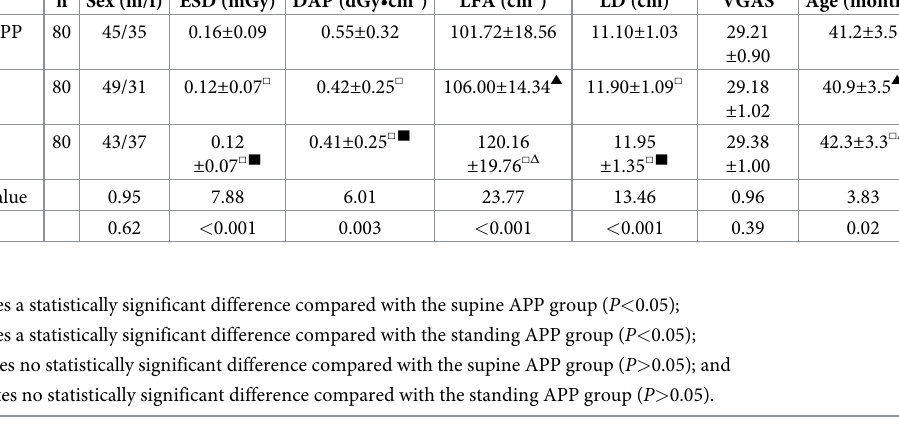
Table 1. Demographic data, radiation dose, and image quality for the supine APP, standing APP, and standing PAP groups (n = 240). n Sex (m/f) ESD (mGy) DAP (dGy•cm 2 )